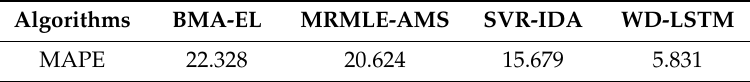
Table 2. Comparison of forecasting errors using di ff erent models.